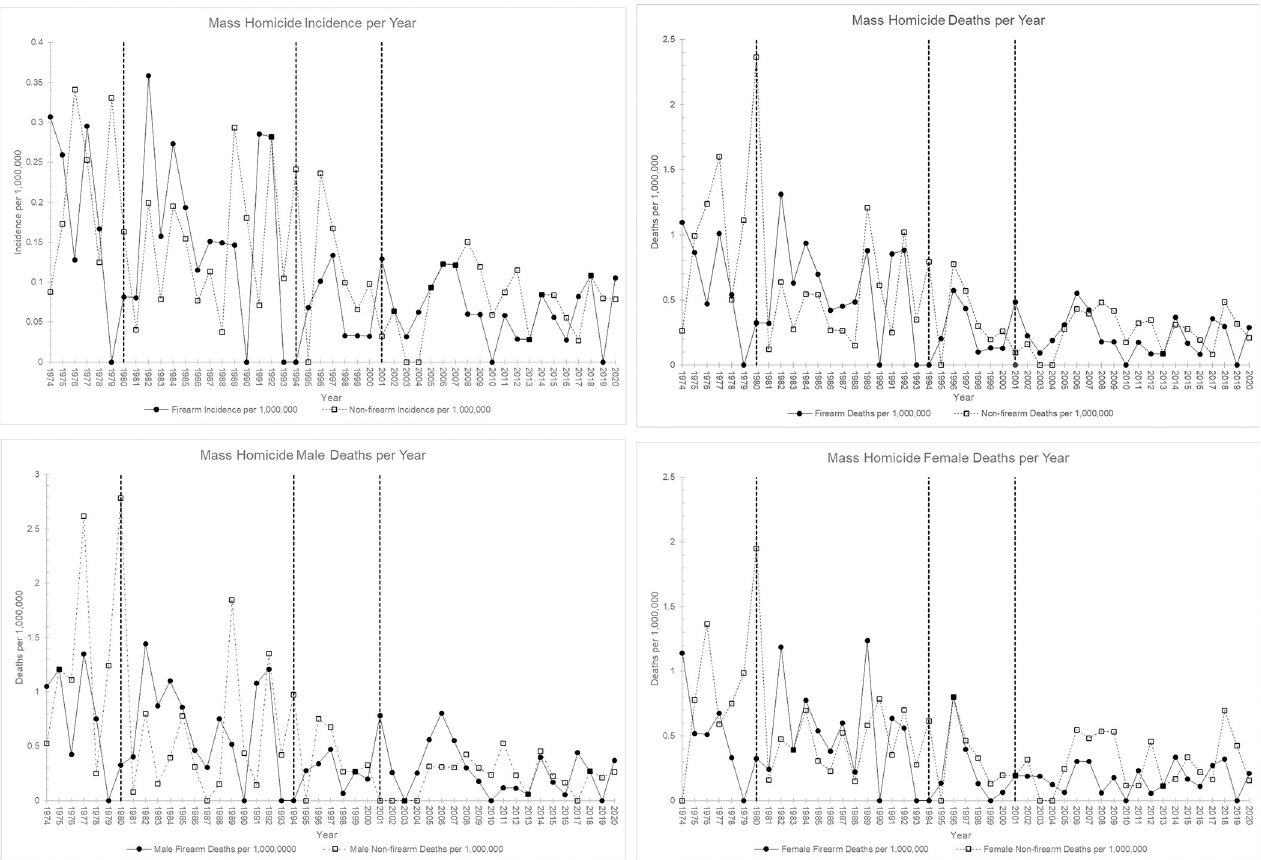
Fig 1. A, Incidence Rate of Mass Homicide per Year. Vertical dashed lines at years 1980, 1994, and 2001 indicate years of interventions. B, Mass Homicide Death Rate per Year. Vertical dashed lines at years 1980, 1994, and 2001 indicate years of interventions. C, Male Death Rate by Mass Homicide per Year. Vertical dashed lines at years 1980, 1994, and 2001 indicate years of interventions. D, Female Death Rate by Mass Homicide per Year. Vertical dashed lines at years 1980, 1994, and 2001 indicate years of interventions.